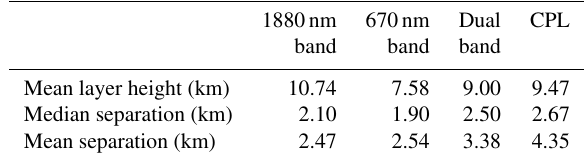
Table 5. Summary of comparison with filters applied. Table 6. Macro